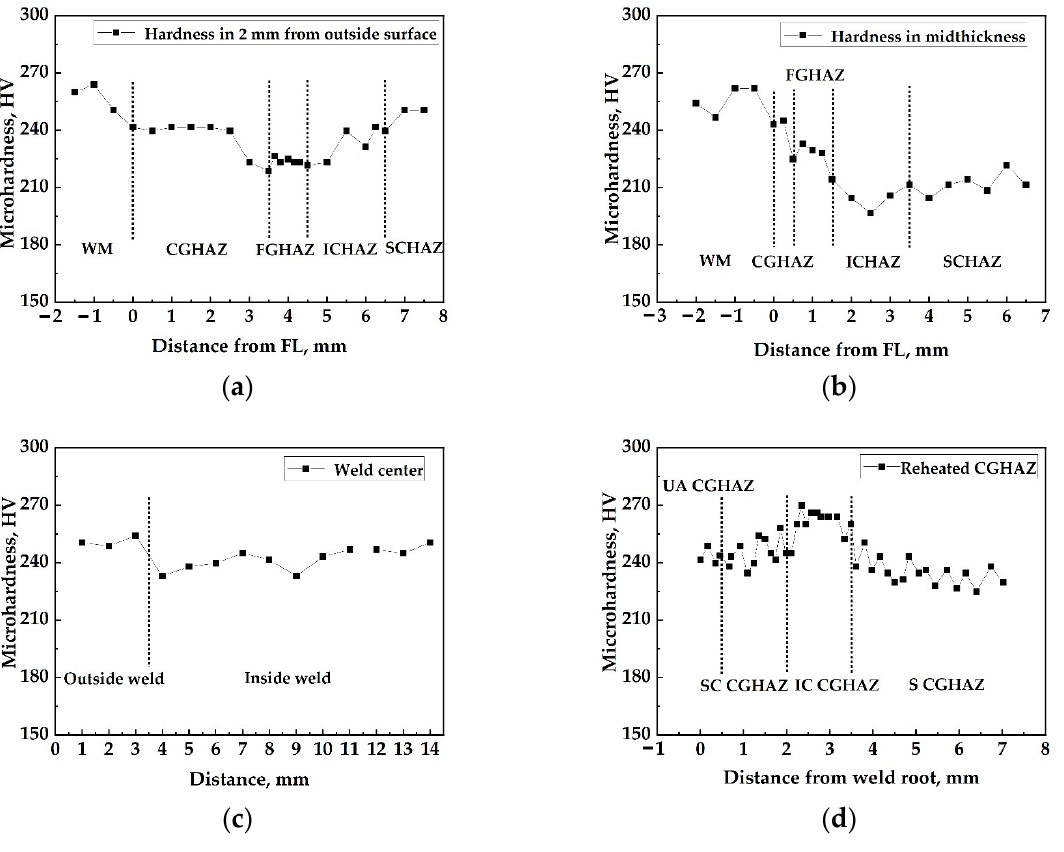
Figure 3. Hardness distribution of the welded joint in different regions. ( a ) 2 mm from outside surface; ( b ) midthickness; ( c ) WM center; ( d ) reheated CGHAZ.